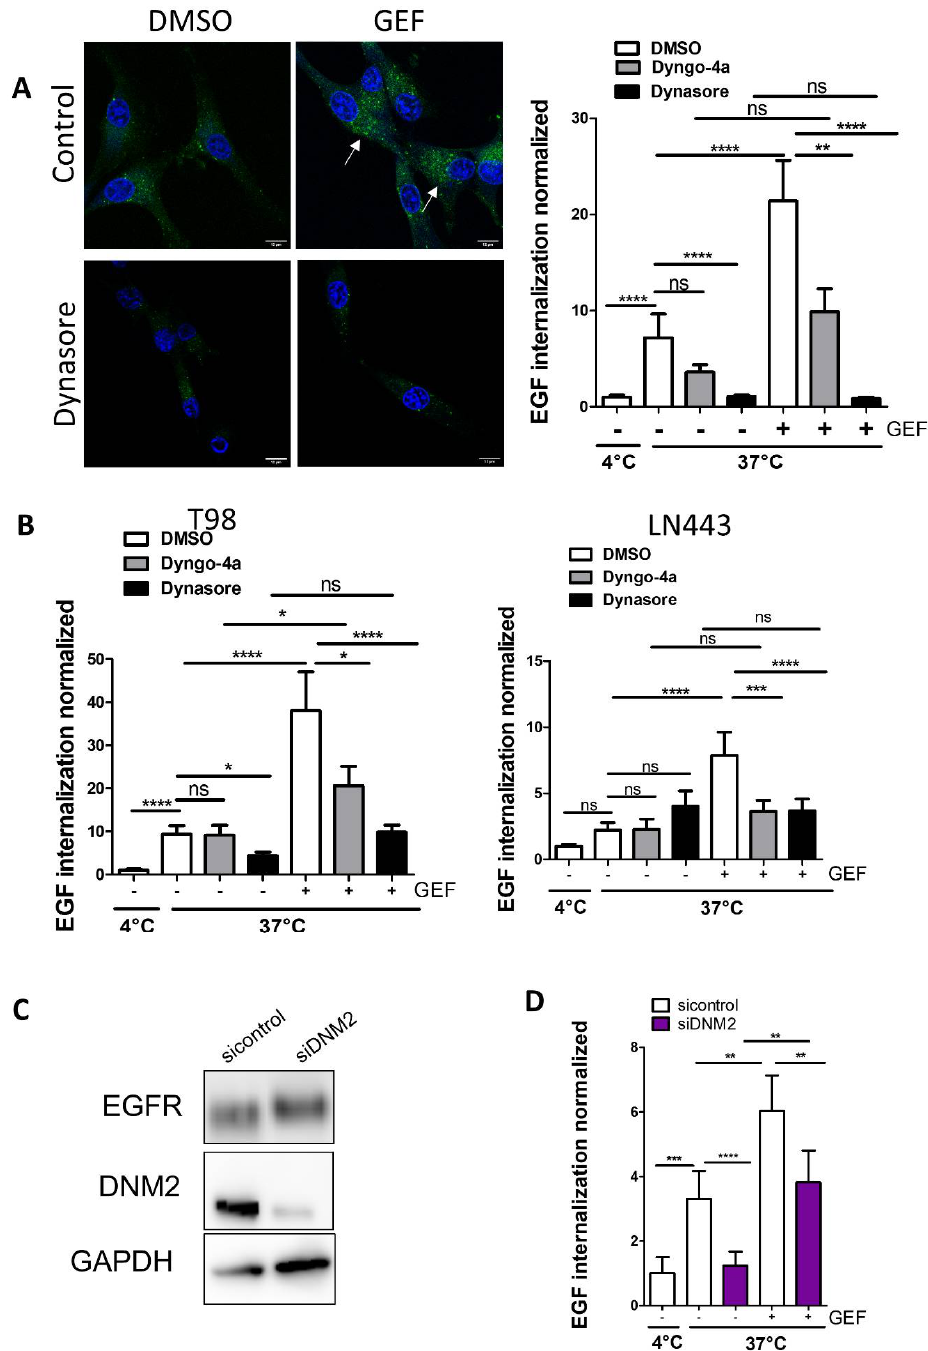
Figure 1. Gefitinib-mediated EGF internalisation is dependent on DNM2. EGF-internalisation assays were performed in the presence gefitinib (20 µ M) for 1 h. ( A , B ) DNM2 GTPase activity was inhibited by treatment with either dynasore (12 µ M) or dyngo-4A (10 µ M) ( A ) Left panel: confocal images of control and dynasore-treated cells, showing, in green, internalised EGF-Alexa Fluor 488 upon incubation at 37 ◦ C. Arrows show internalised EGF. Scale bar = 12 µ m. Right panel: the internalisation was quantified by integrated fluorescence density on 20 cells of 3 independent experiments. Data reported as column histograms are the mean with 95% CI. ( B ) Results were confirmed in other GBM cell lines. EGF-internalisation assays were performed in T98 and LN443 cells using dynasore and dyngo-4A as described in A. ( C ) Downregulation of DNM2 expression was obtained by siRNA-DNM2 mediated silencing. DNM2 silencing was confirmed by immunoblotting after 72 h. EGFR protein was also immunodetected and remained constant in both conditions. GAPDH was used as the loading control. ( D ) EGF-internalisation assays were performed on U87 cells transfected with siRNA-control or U87 siRNA-DNM2. * p < 0.5; ** p < 0.01; *** p < 0.001; **** p < 0.0001; ns: not